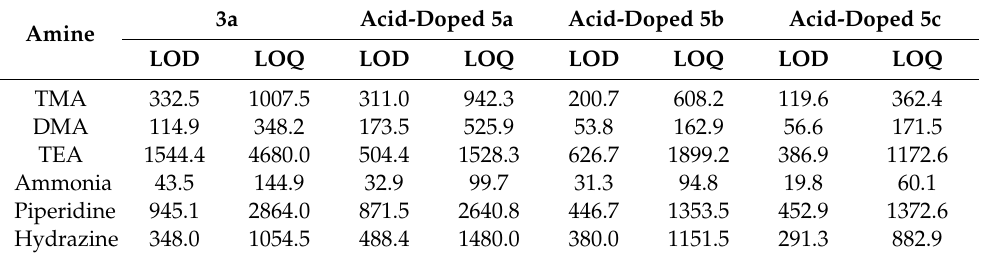
Table 1. Limit of detection (LOD) and limit of quantitation (LOQ) ( µ g / mL) of using 3a and acid-doped 5a – c as the colorimetric indicators for the detection of di ff erent volatile